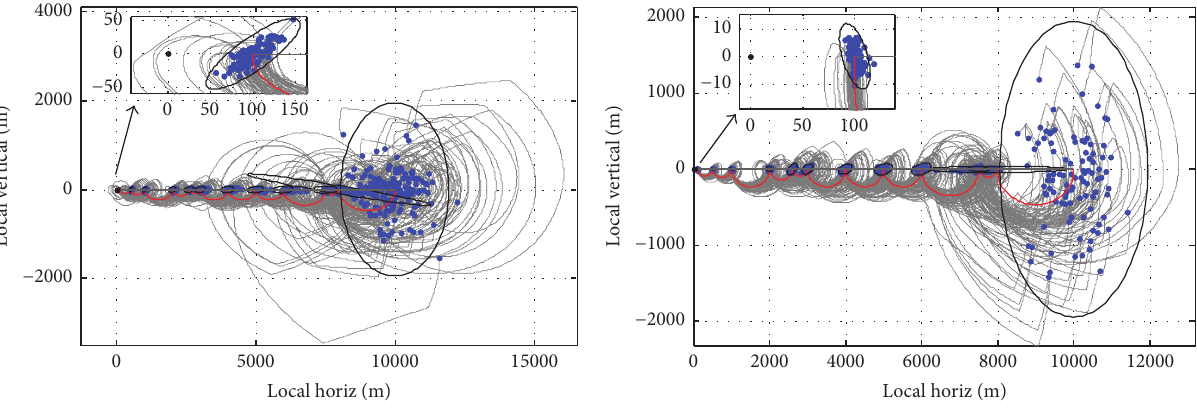
(b) Time and covariance threshold triggered optical maneuver profile Figure 4: Monte Carlo shooting.